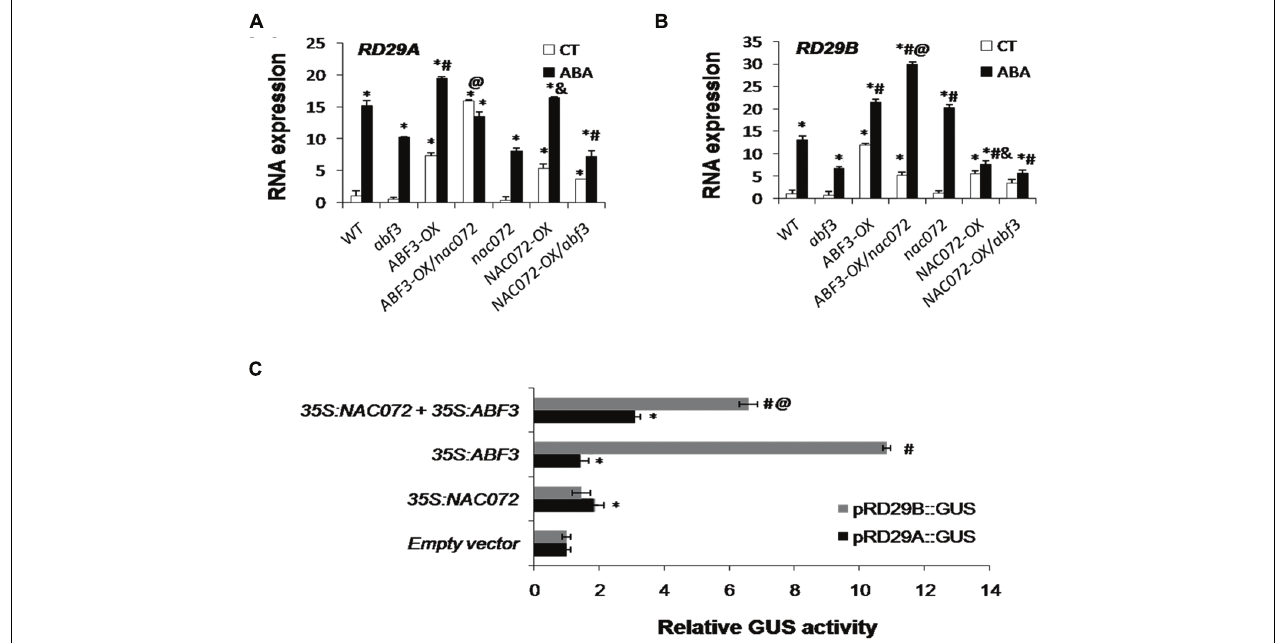
FIGURE 3 | NAC072 cooperates with or antagonizes ABF3-mediated ABA-responsive gene regulation. (A) Expression of RD29A in each mutant, transgenic line and WT plants under control treatment (CT) or 100 µ M ABA treatment (ABA) for 2 h. ‘ ∗ ’ or ‘ # ’ indicates a significant difference between ABF3 or NAC072 transgenic plants compared with WT or abf3 and nac072 plants under CT and ABA treatments, respectively ( P < 0.05). ‘@’ indicates a significant difference between ABF3-OX and ABF3-OX/nac072 plants ( P < 0.05). ‘&’ indicates a significant difference between NAC072-OX and NAC072-OX/abf3 plants ( P < 0.05). (B) RD29B in each mutant, transgenic and WT plants under CT or ABA treatment for 2 h. ‘&’ indicates a significant difference between NAC072-OX and nac072 mutants. (C) Transactivation of the RD29A or RD29B promoter-GUS fusion gene by ABF3 and/or NAC072 in Arabidopsis protoplasts. The reporter gene was transfected with each effecter plasmid ( 35S:ABF3 and/or 35S:NAC072 ) or the empty vector as a control groups. Co-transfection of the 35S driving luciferase ( LUC ) plasmid was used in each experiment to normalize transfection efficiency. Protoplasts were prepared from rosette leaves of 4-weeks-old WT. Bars indicate standard deviation, n = 3. ‘ ∗ ’ or ‘ # ’ indicates a significant difference between ABF3 or NAC072 groups compared with control groups ( P < 0.05). ‘@’ indicates a significant difference between ABF3 and NAC072 compared with ABF3 alone ( P <